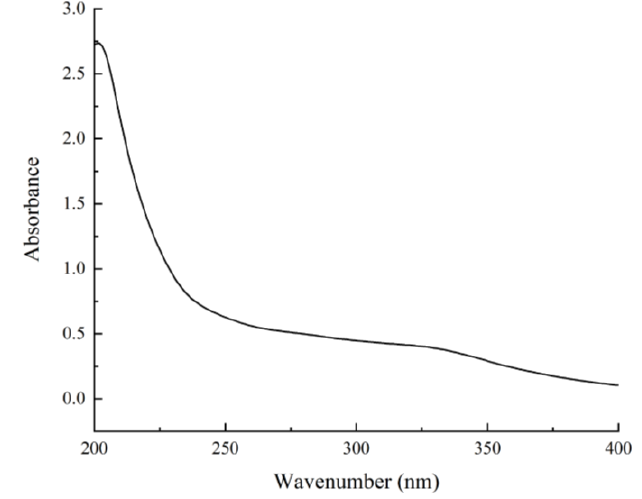
Figure 3. UV-visible spectrum of BCP.